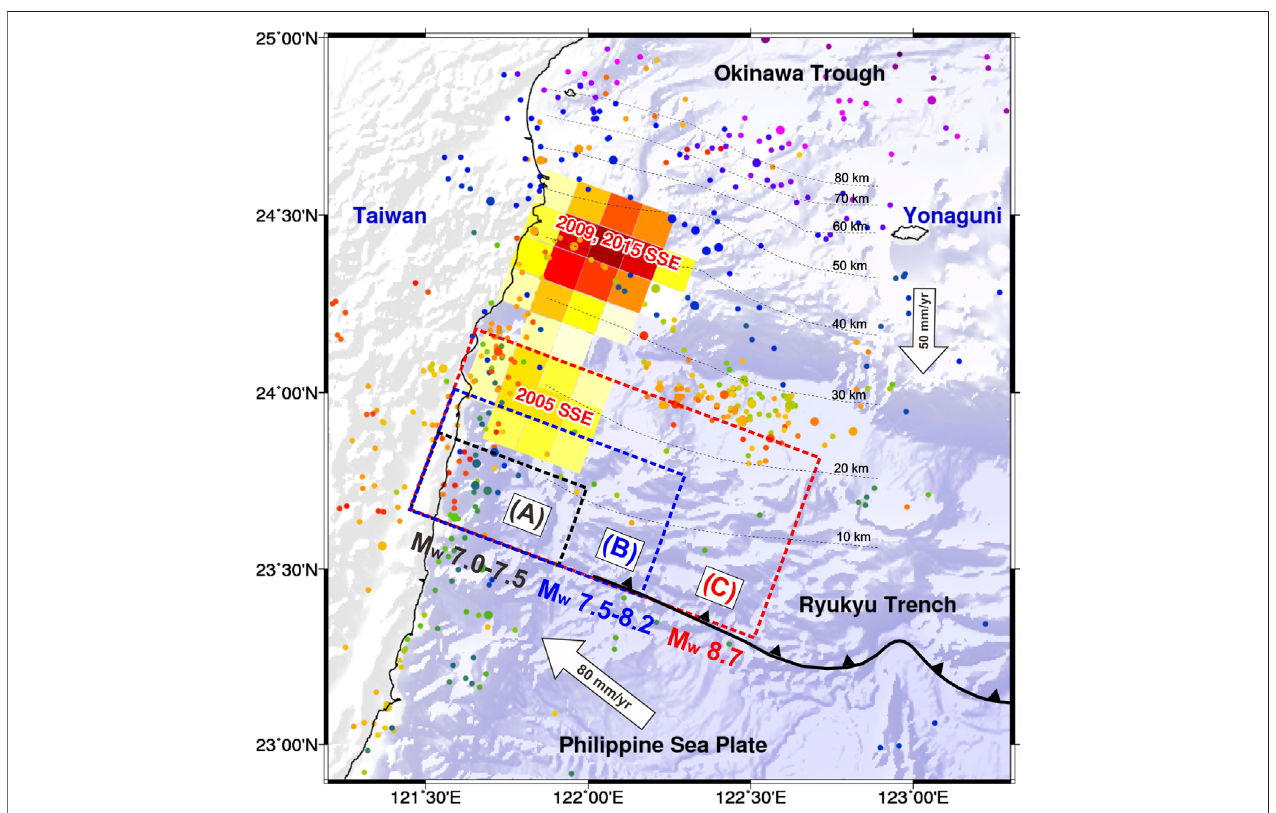
FIGURE 8 | Schematic view of the three possible rupture scenarios of the Ryukyu fault. The black, blue, and red dotted rectangles represent the scenarios from types (A – C) , respectively (refer to the discussion). The other captions are the same as in Figure 1 .